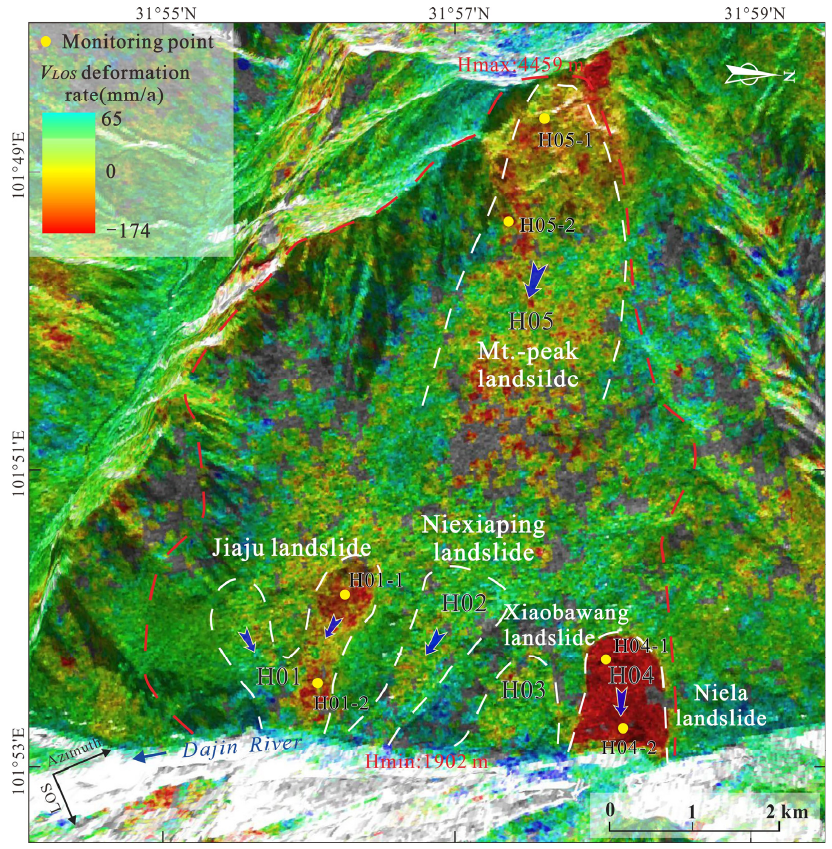
Figure 5. Deformation rate distribution map of the Jiaju ancient landslide in the LOS